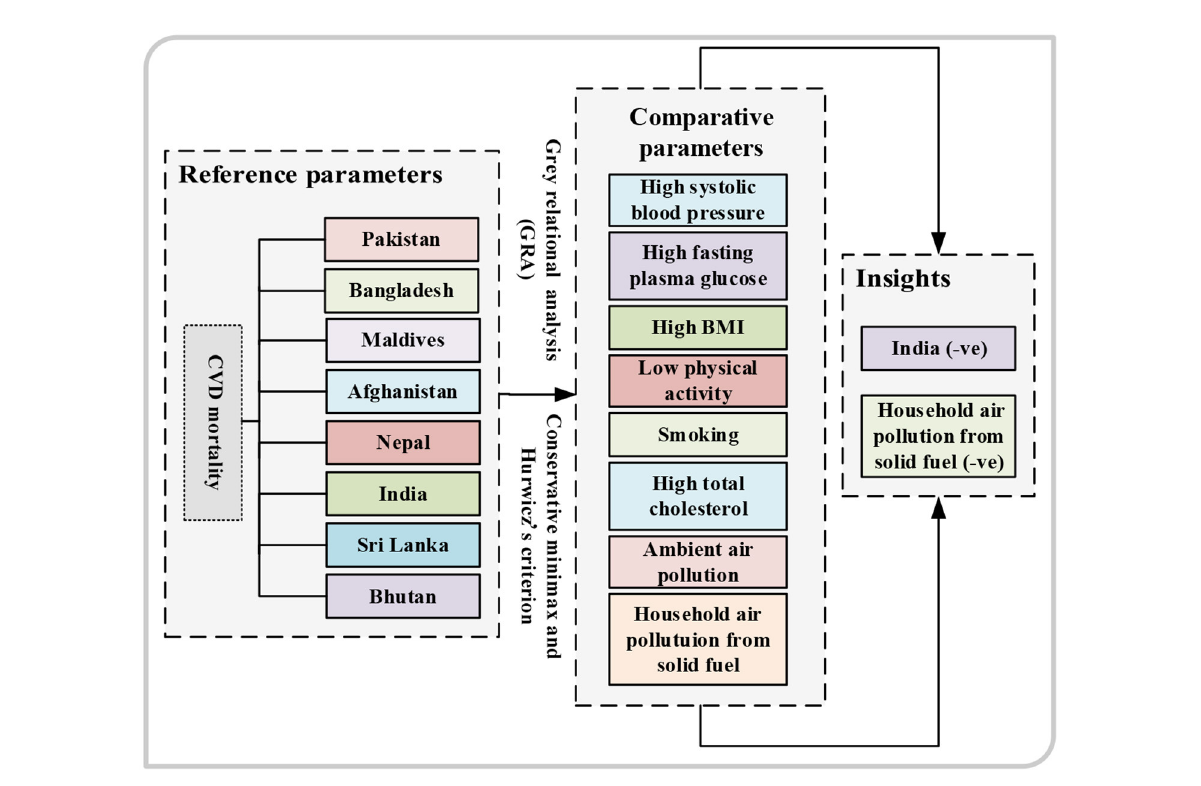
FIGURE1 The graphical